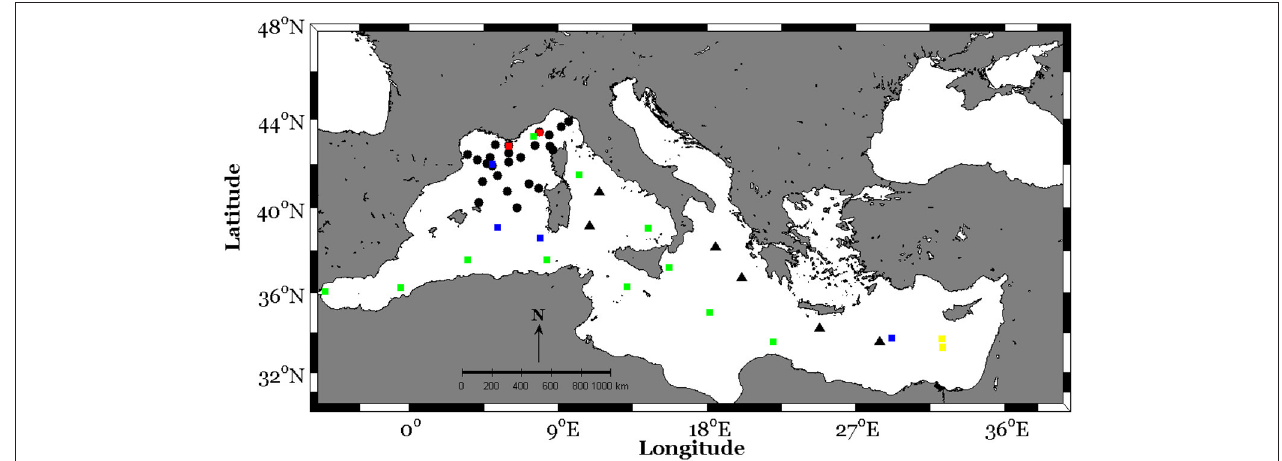
FIGURE 1 | Station locations in the North Western Mediterranean Sea (MOOSE-GE cruise, black circles) and along an E-W transect crossing Ionian and Tyrrhenian seas (BioArgomed cruise, black triangles). The squares represent sampling stations from published studies reporting nanomolar dissolved inorganic phosphate in the Mediterranean Sea (green squares: PROSOPE cruise, 1999; blue squares: BOUM cruise, 2008; red squares: MOOSE-ANTARES and MOOSE-DYFAMED fixed stations, see Table 1 for references).